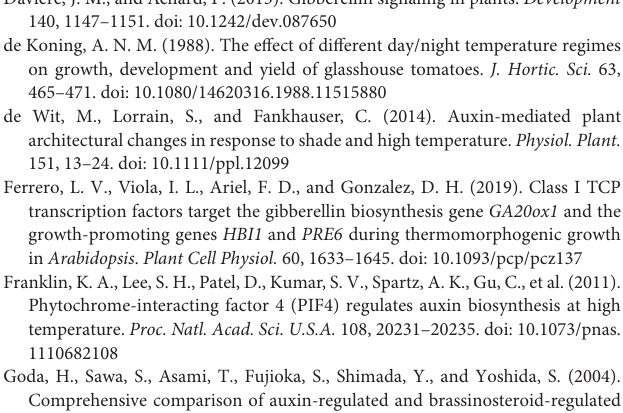
Supplementary Figure 1 | Schematic representation of growth conditions in the study. (A) Control temperature treatment, 25 ◦ C/20 ◦ C (DT/NT). (B) High temperature/positive DIF treatment, 30 ◦ C/25 ◦ C (DT/NT). (C) Negative DIF treatment, 25 ◦ C/30 ◦ C (DT/NT). Young tomato seedlings were grown for 7 days under each condition. White bars show the light period, black bars show the dark